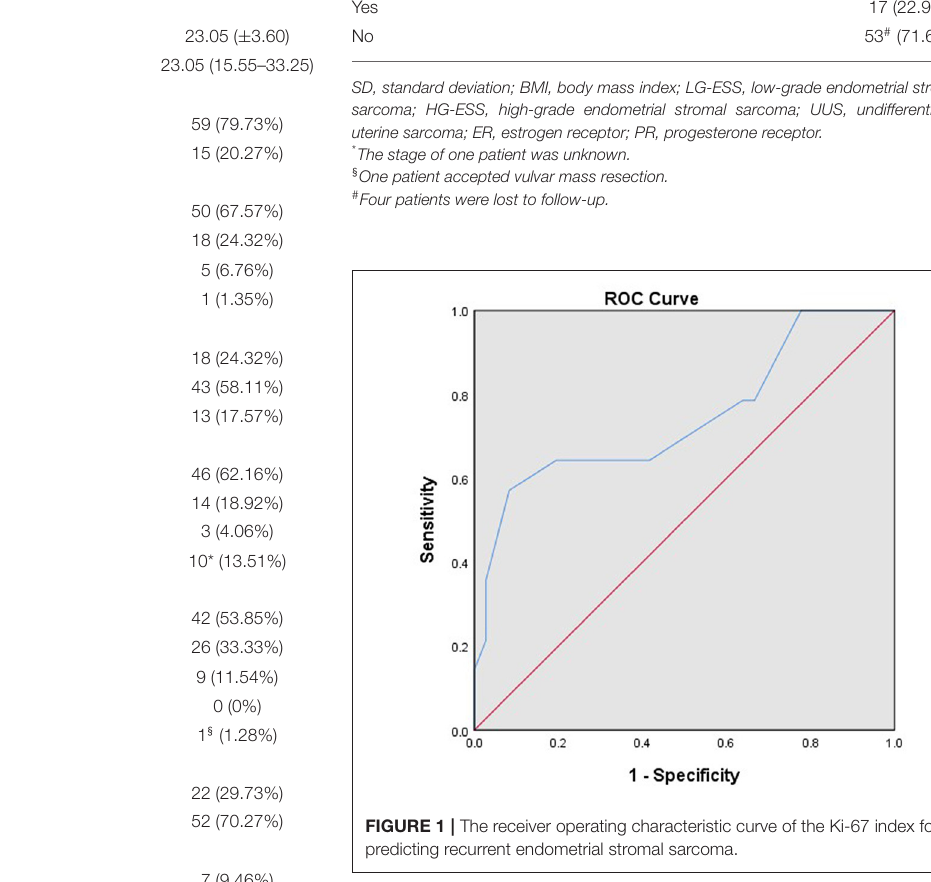
surgery were excluded, and four patients who were unable to perform satisfactory tumor reduction surgery and only took biopsy were excluded. The final analysis includes 74 patients with endometrial stromal sarcoma. Clinicopathological features of these patients are listed in Table 1 . Most patients have International Federation of Gynecology and Obstetrics (FIGO) Stage I tumors (46/74, 62.16%). The patients with low-grade endometrial stromal sarcoma account for 67.57% (50/74). The median follow-up time of the patients with endometrial stromal sarcoma was 53 months, ranging from 7 to 132 months. There are 17 patients with recurrent endometrial stromal sarcoma, 11 of them died due to recurrence. According to receiver operating characteristic curve and the Youden index, the optimal cut-off value of the Ki-67 index for predicting recurrent endometrial stromal sarcoma was 35% ( Figure 1 ). The area under the curve was 0.743 [95% CI: 0.574–0.912], and the sensitivity, specificity, and accuracy were 57.1, 91.7, and 74.6%,